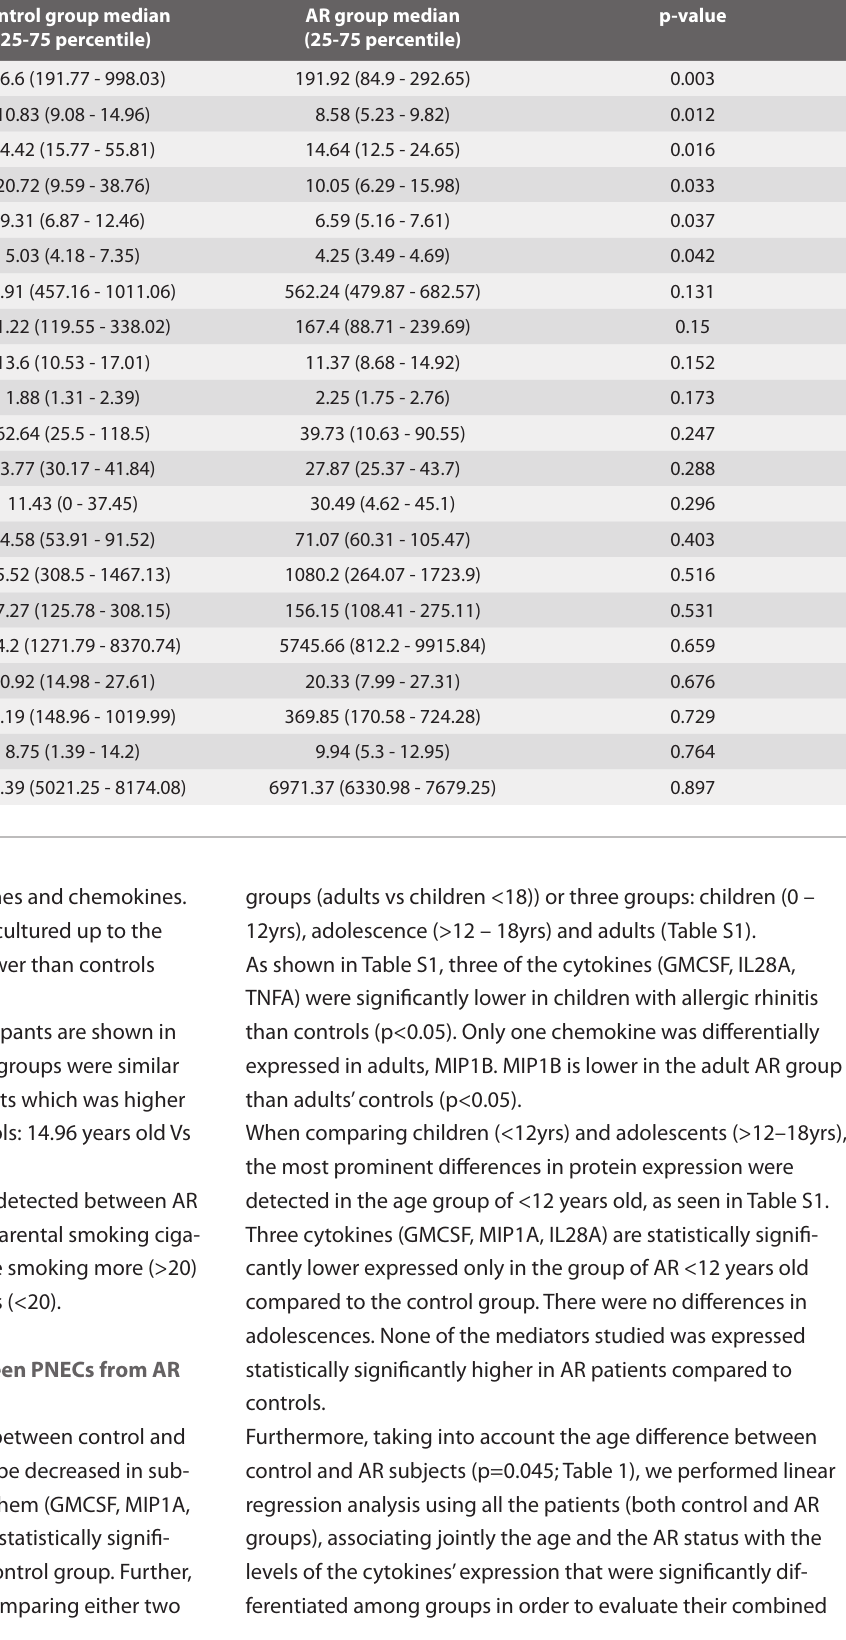
Table 2. Comparing the protein expression levels between control and AR PNECs; the comparisons have been performed with Wilcoxon’s rank-sum test, while descriptive statistics are given in the form of median (25th - 75th